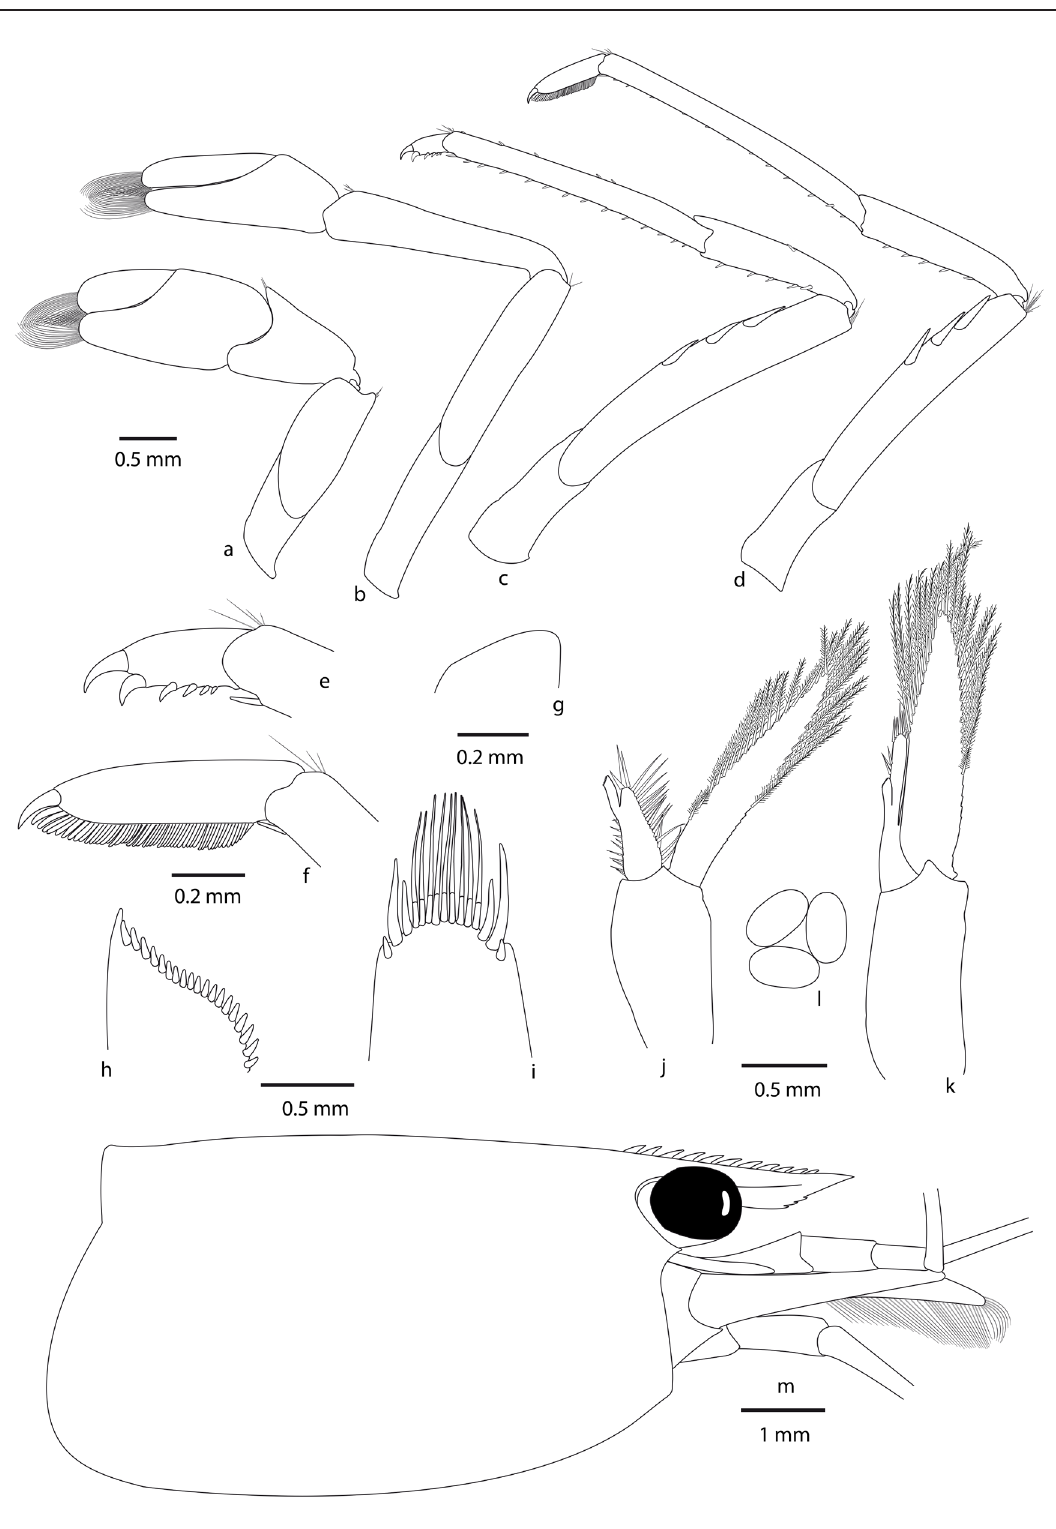
Fig. 15. Caridina weberi De Man, 1892. a . First pereiopod. b . Second pereiopod. c . Third pereiopod. d . Fifth pereiopod. e . Dactylus of third pereiopod. f . Dactylus of fifth pereiopod. g . Pre-anal carina. h . Uropodal diaeresis. i . Telson. j . First male pleopod. k . Second male pleopod. l . Eggs. m . Cephalothorax. MNHN-IU-2018-2867 (a–i, l–m) and MNHN-IU-2018-2870